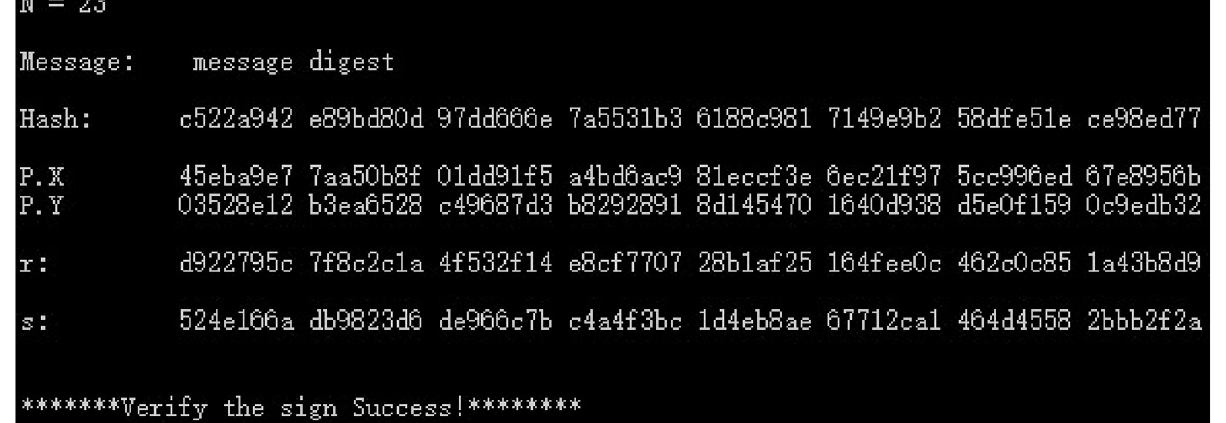
Fig 9. 23-party co-digital signature and verification data.